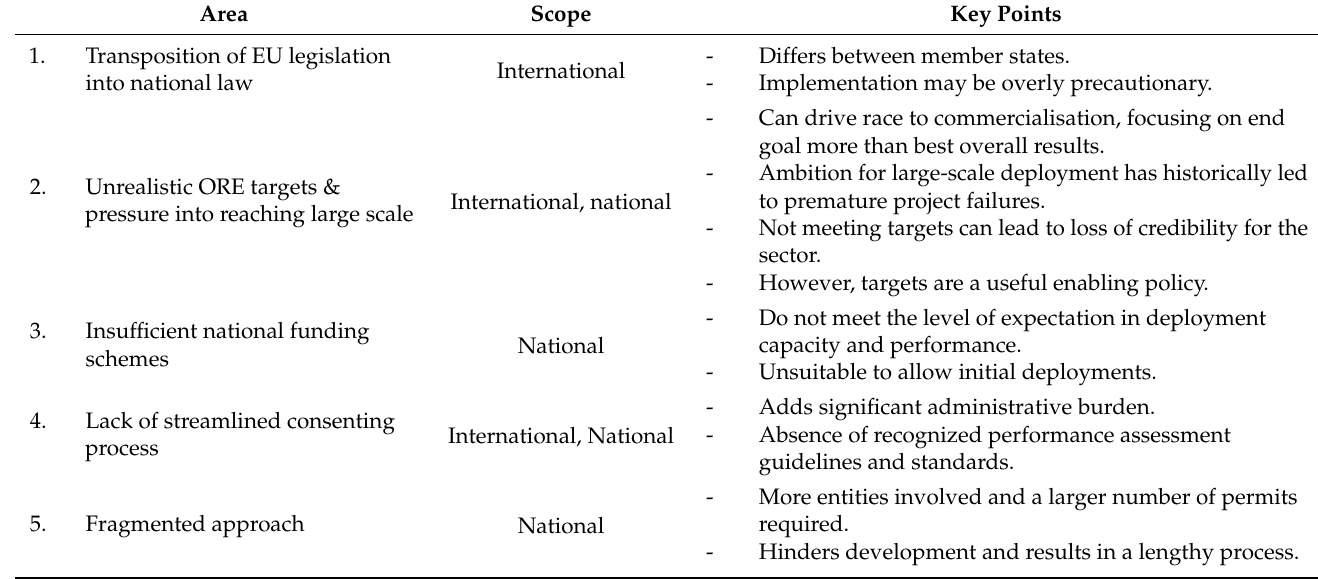
Table 4. Summary of main